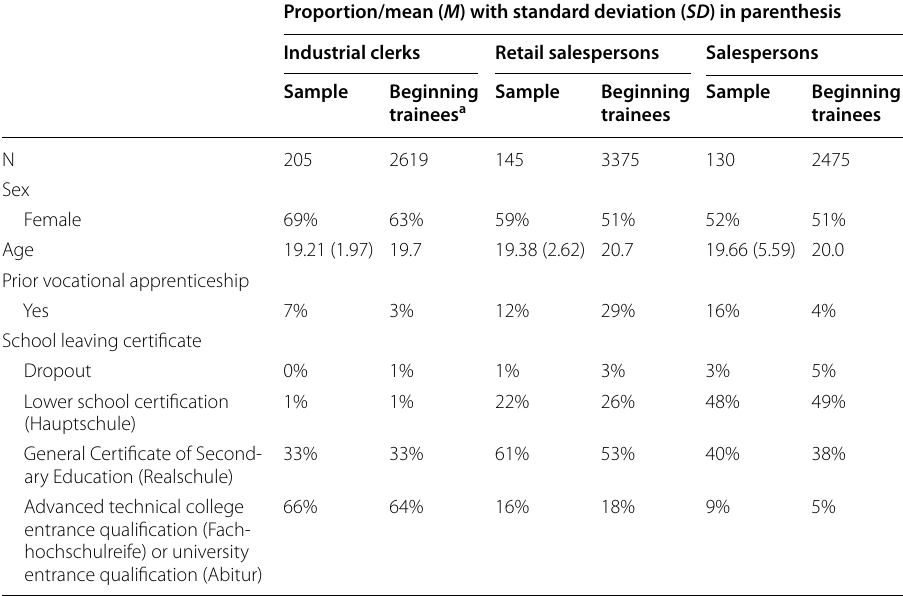
a Numbers referring to all trainees in the federal state of Baden-Wuerttemberg, who started the respective training program in 2020